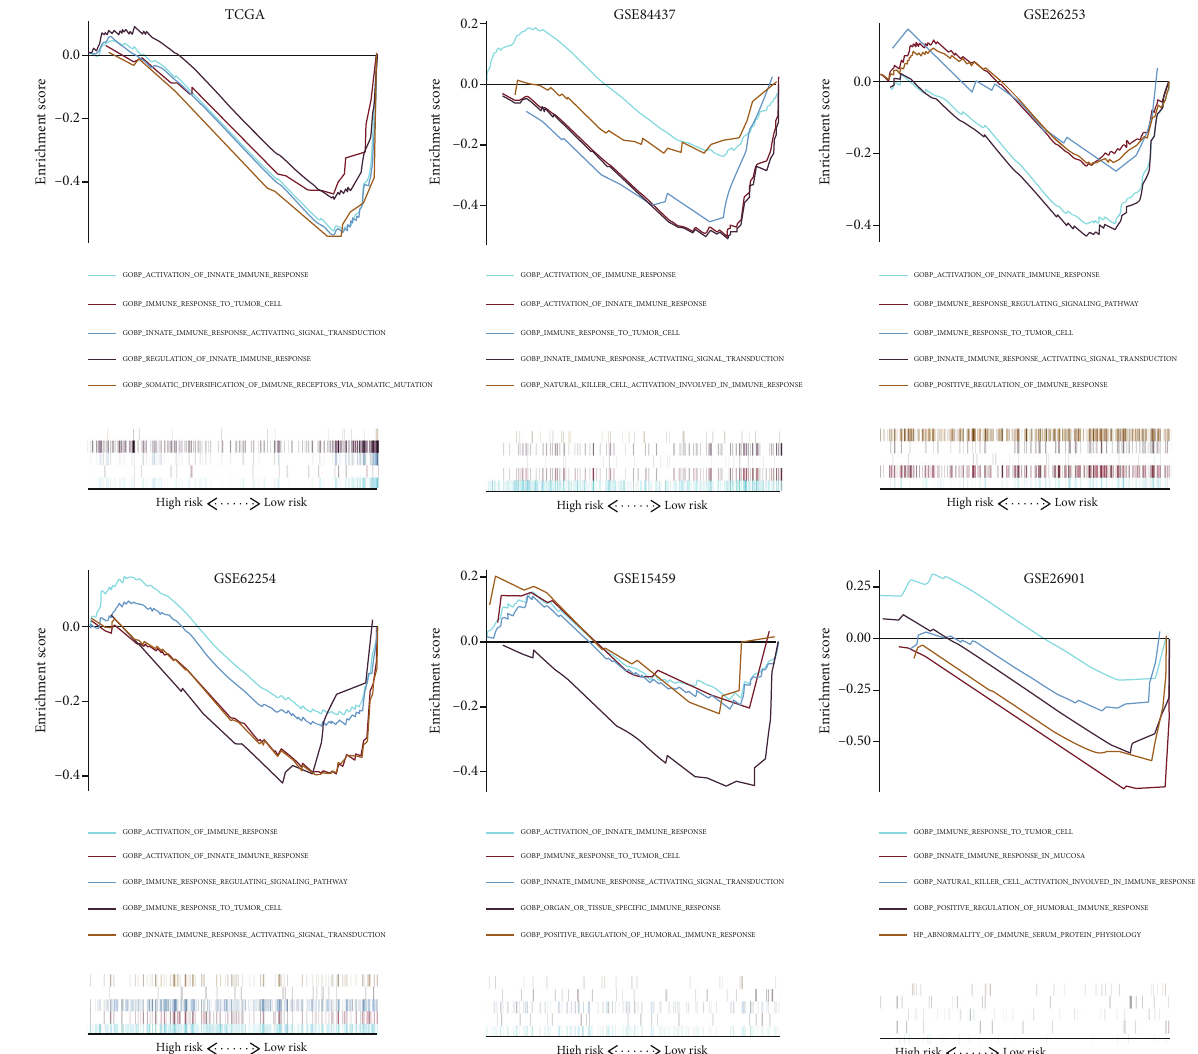
Figure 8: Gene set enrichment analysis for immune-related pathways in di ff erent risk